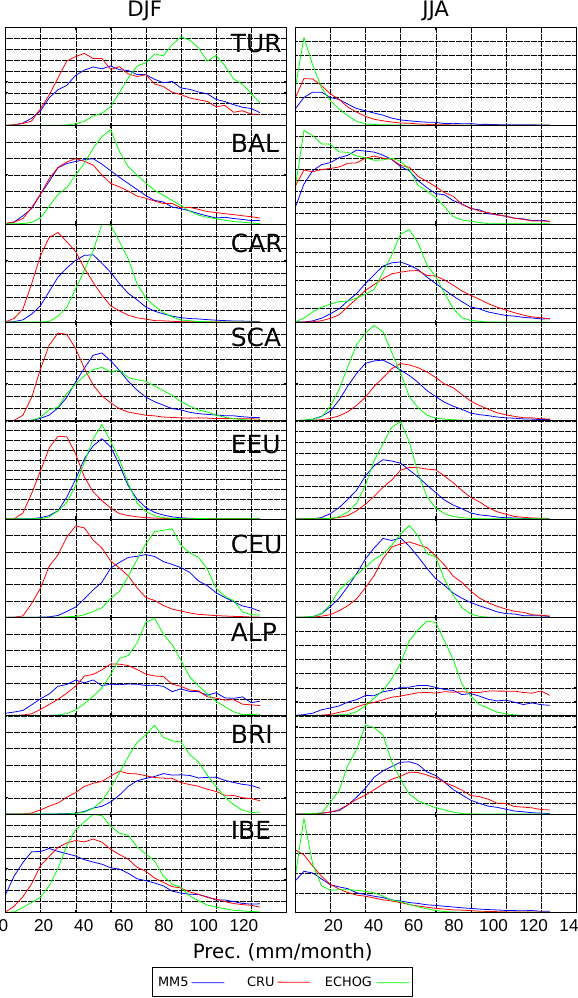
Fig. 10. PDFs of seasonal series of SAT in the nine sub-areas of Europe shown in Fig. 2. The results for winter (left panels) and summer (right panels) are presented for MM5, CRU and ECHO- G. The horizontal axis shows the units of SAT in Celsius degree, while the vertical indicates relative frequency in arbitrary units.